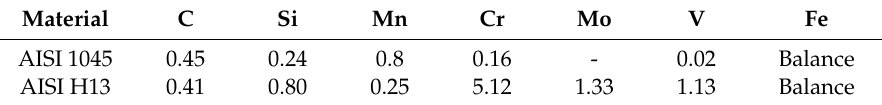
Table 1. Chemical compositions (wt %) of AISI 1045 [21] and AISI H13